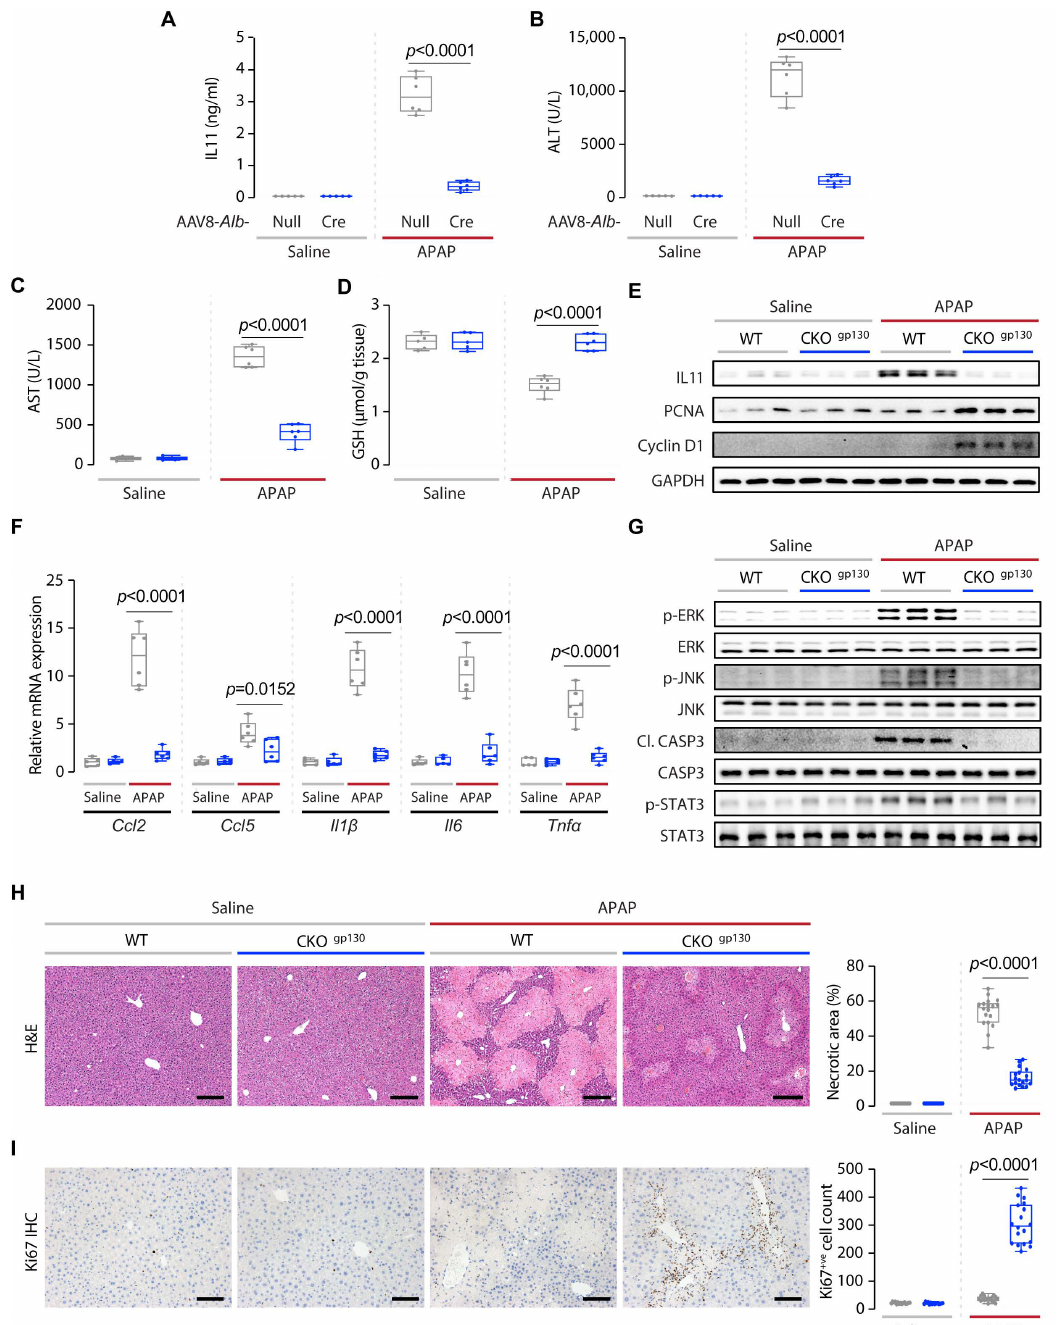
Figure 3. Hepatocyte-specific deletion of gp130 limits APAP-induced liver injury and promotes hepatic regeneration 24 h after injury. ( A ) Serum IL11 levels, ( B ) serum ALT levels, ( C ) serum AST levels, ( D ) hepatic GSH levels, ( E ) Western blots showing hepatic levels of IL11, PCNA, Cyclin D1, and GAPDH as internal contro ( n = 3/group)l, ( F ) hepatic mRNA expression of pro-inflammatory markers ( Ccl2 , Ccl5 , Il1 β , Il6 , Tnf α ), ( G ) Western blots showing hepatic levels of p-ERK, ERK, p-JNK, JNK, Cl. CASP3, CASP3, p-STAT3, and STAT3 ( n = 3/group), ( H ) representative H&E-stained liver images (scale bars, 200 µ m) and quantification of liver necrotic area, ( I ) IHC staining of Ki67 in the livers of mice (scale bars, 200 µ m) and quantification of Ki67 +ve cells for experiments shown in Figure 2B. ( A – D , F , H , I ) Saline ( n = 5 mice/genotype), APAP ( n = 6 mice/genotype); data are shown in a box-and-whisker plot with median (middle line), 25th–75th percentiles (box), and min-max values (whiskers), with a 2-way ANOVA with Sidak’s